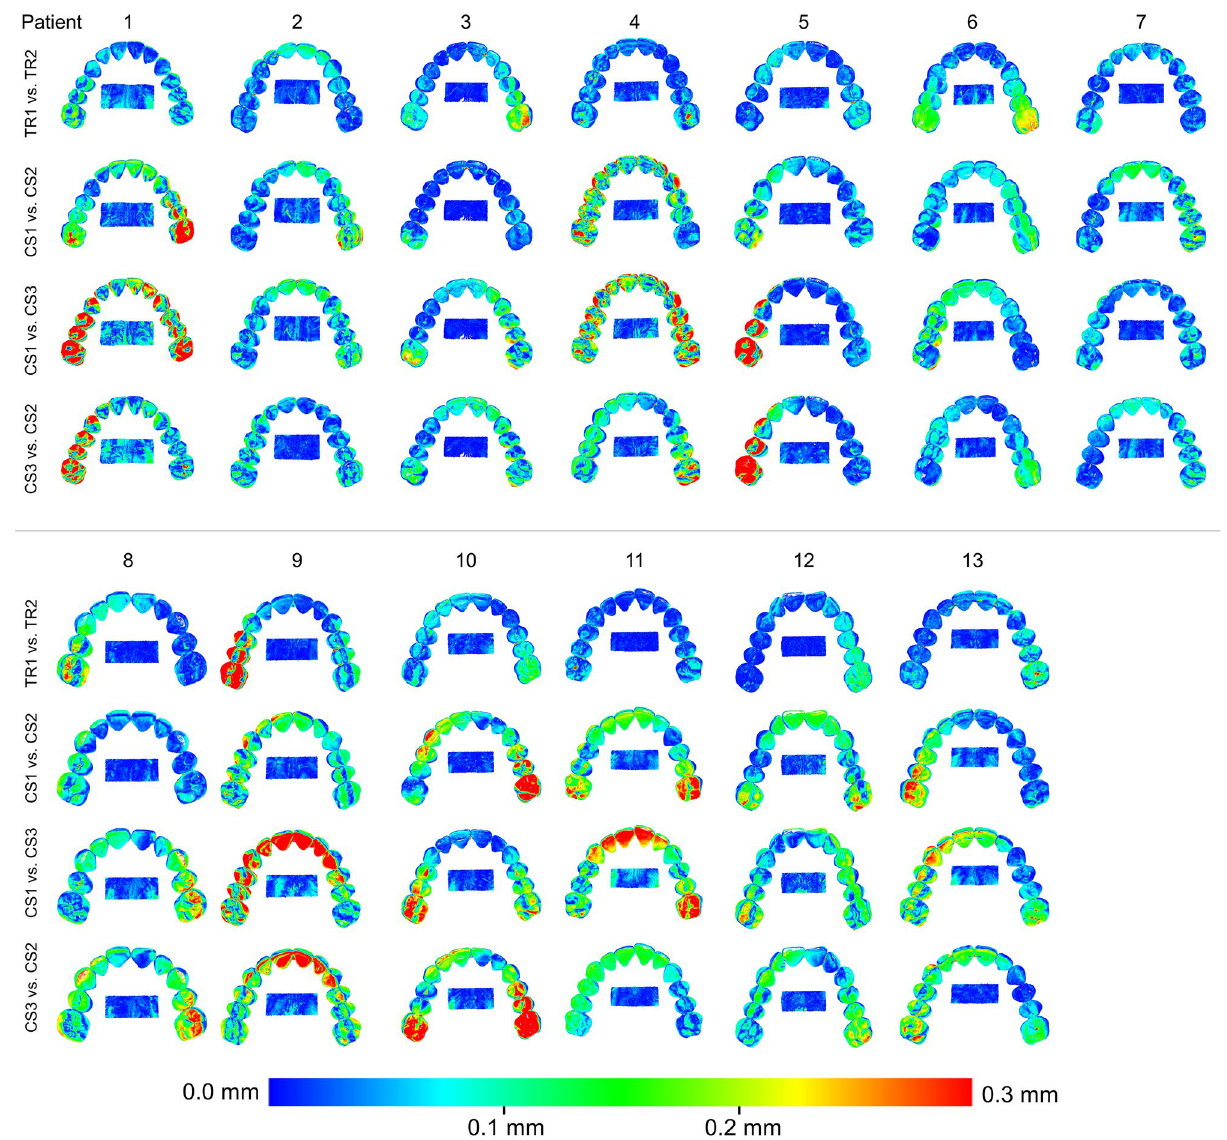
Figure 6. Colour coded distance maps showing the precision of the intraoral scanners on the dental arch area, when superimposed on palatal area A. Three scans from CS 3600 (CS1, CS2, CS3) and two scans from TRIOS3 (TR1, TR2) were assessed. All images were generated using Viewbox 4 software (version 4.1.0.1 BETA, http:// www. dhal. com/ viewb oxind ex.